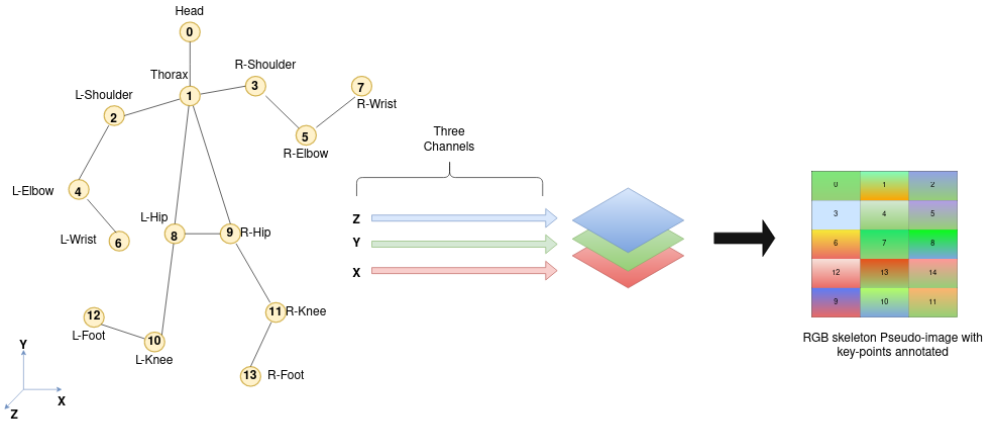
Figure 2. Organization of the 3D skeleton data structure into a three-channel image